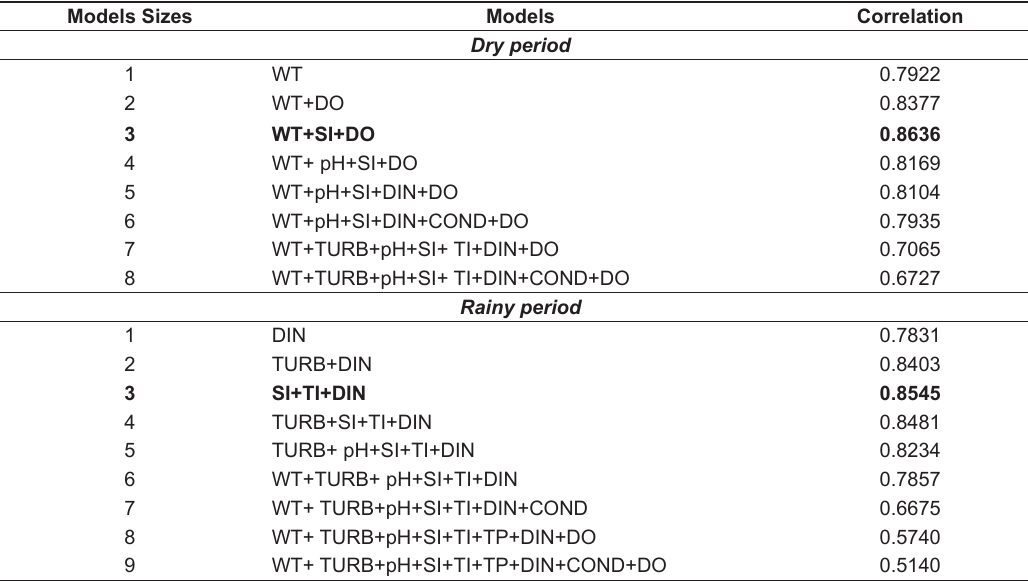
Table 3. Results of the BioEnv for phytoplankton density during a dry and rainy period in the João Leite reservoir. Models